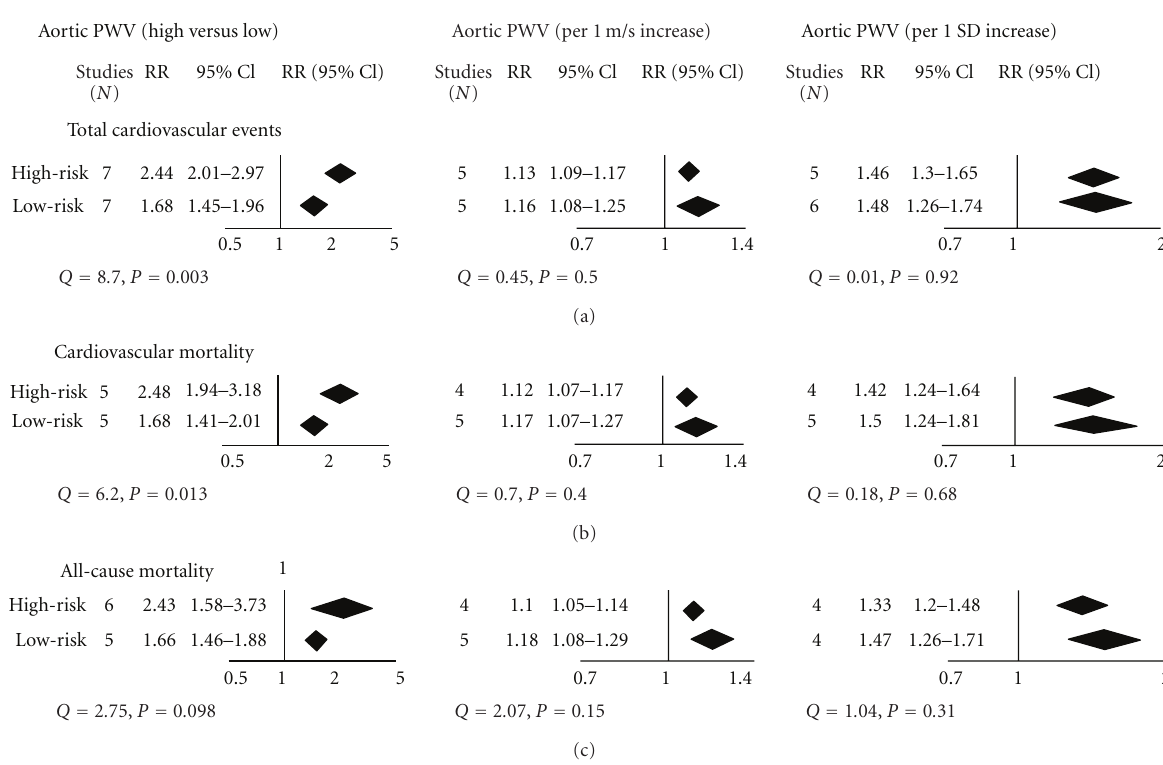
Figure 3: This figure shows pooled RR and 95% CI for aortic PWV and total CV events (a), CV mortality (b), and total mortality (c), according to baseline risk and disease state. Data are provided for high versus low aortic pulse wave velocity (PWV) (left column), increase in aortic PWV by 1m/s (middle column), and increase in aortic PWV by 1 SD (right column) (see